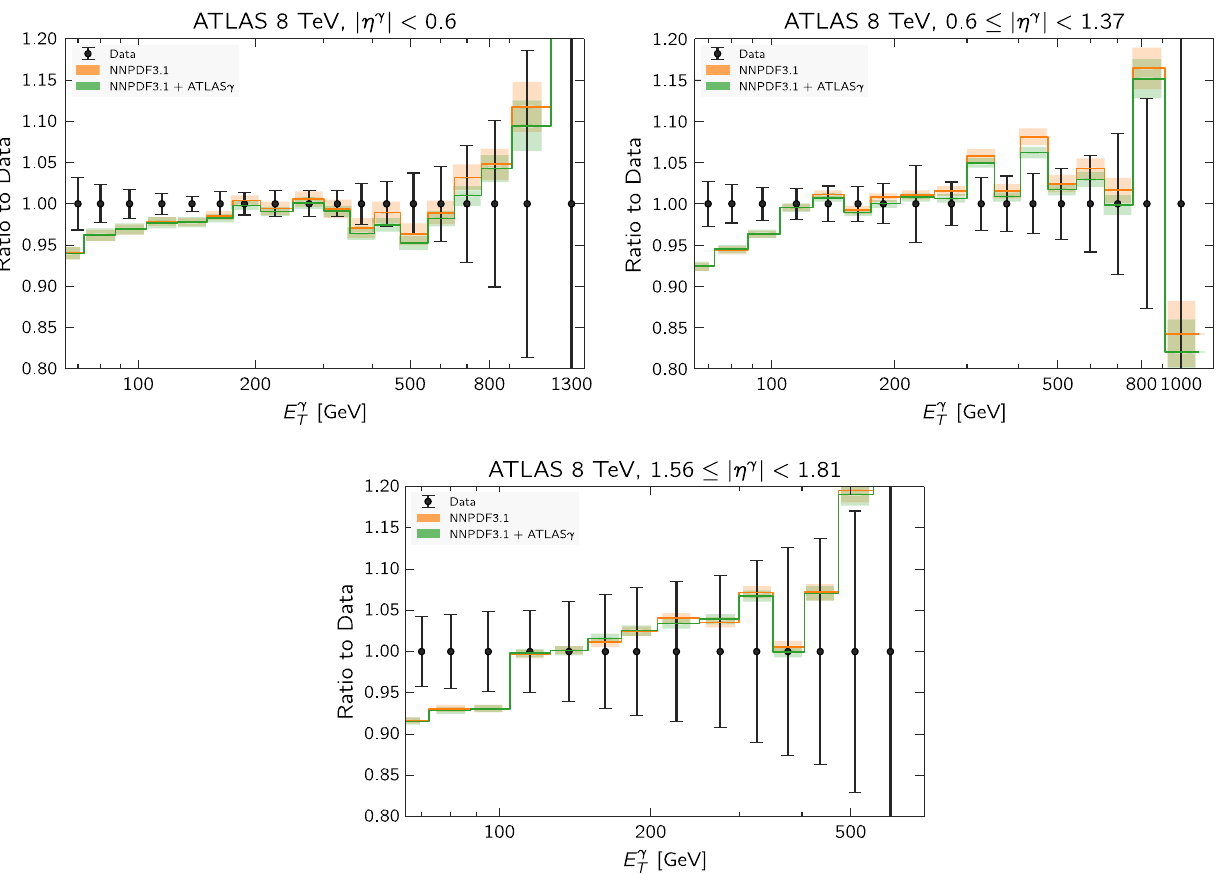
Fig. 8 Same as Fig. 5, now comparing the NNPDF3.1 and NNPDF3.1 + ATLAS γ sets for the three rapidity bins of the ATLAS 8 TeV data included in the